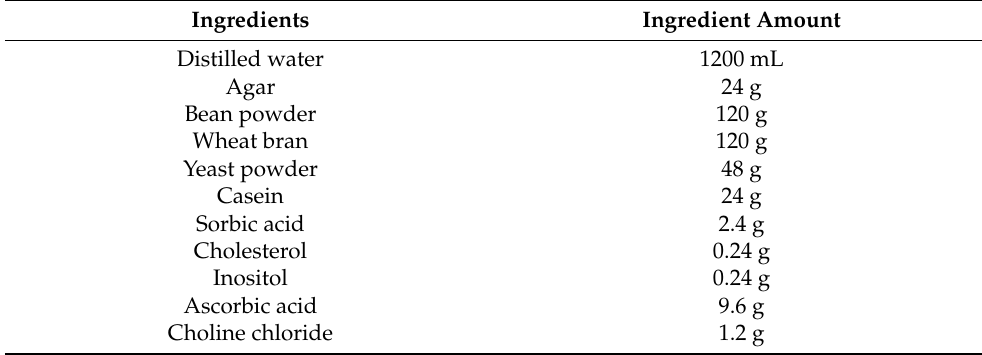
Table 1. Artificial diet for Spodoptera frugiperda